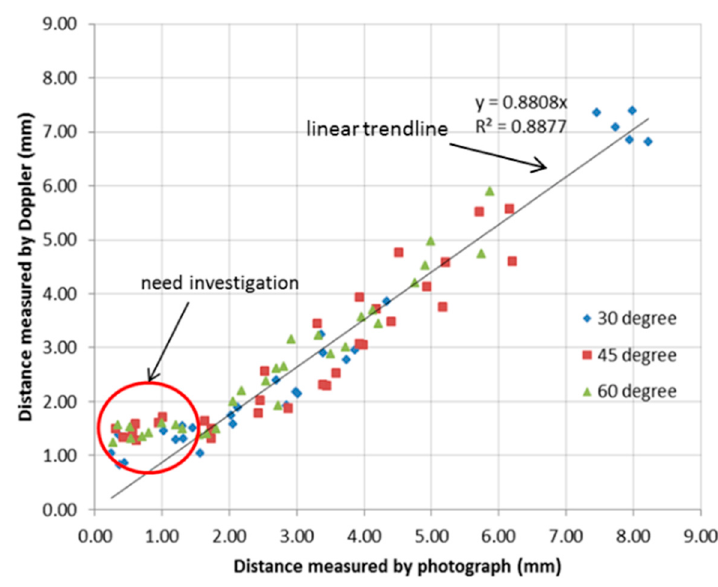
Figure 7. Linear regression analysis of the paired Doppler and photographic measurements.